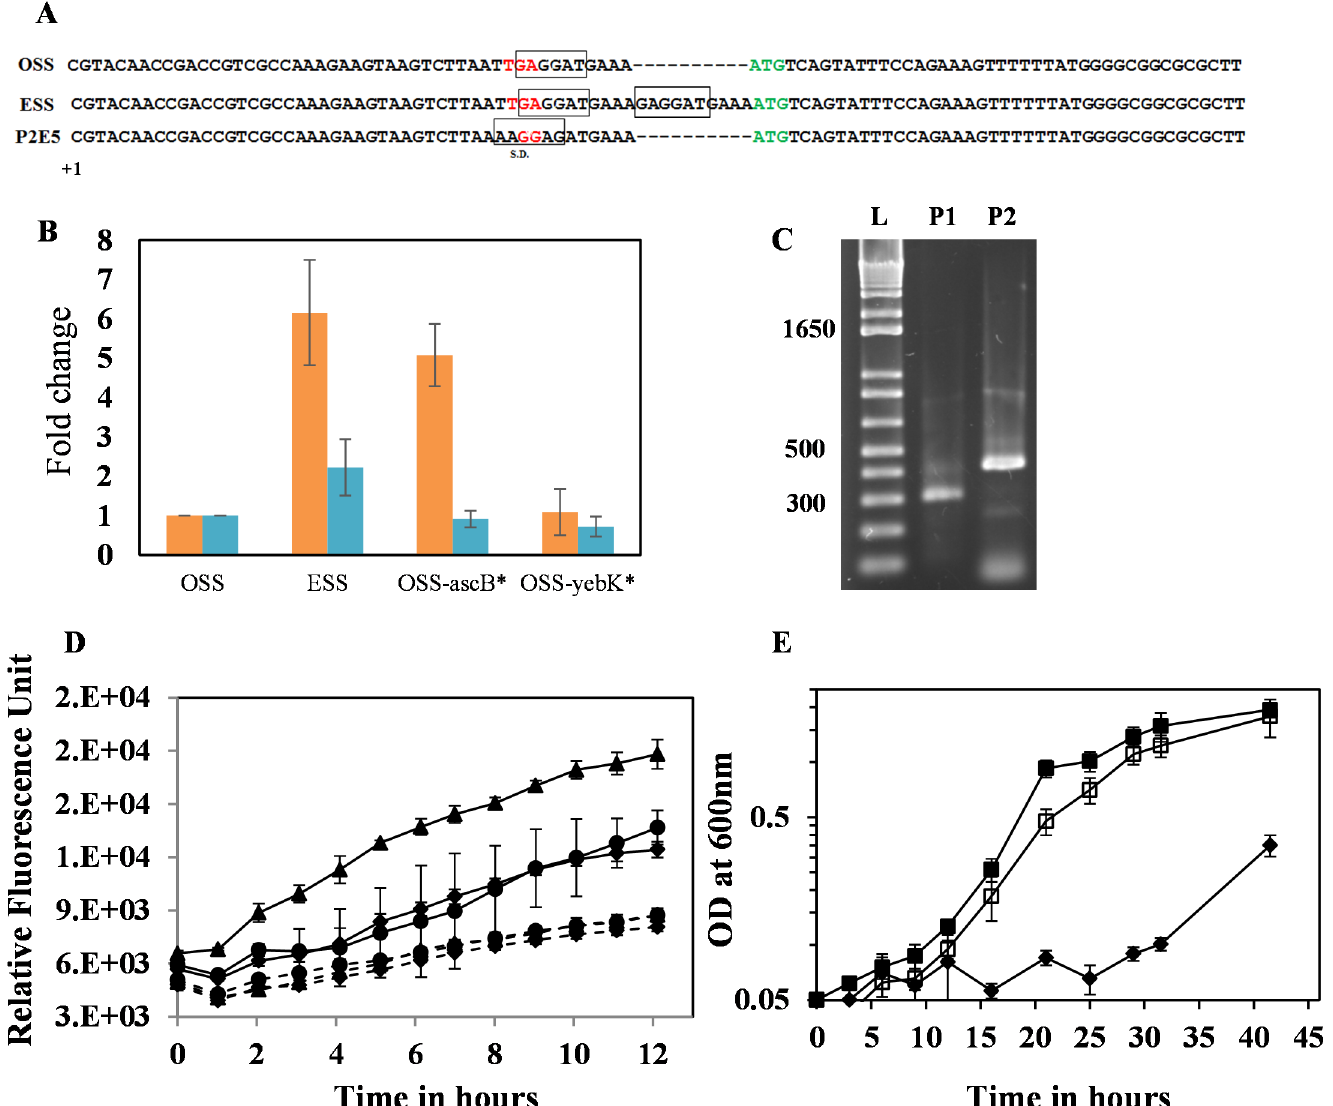
Fig 2. (A) Figure indicating the predicted RBS of OSS and the duplicated sequence observed in strain ESS. The two putative RBS of strain ESS are shown in boxes. The figure also indicates the mutated RBS in strain P2E5 obtained through genome engineering. The new transcription start site of ascB gene was marked as +1. (B) Fold change in the expression level of ascB ( orange ) or ascF ( blue ) in ESS, OSS- yebK * , and OSS- ascB * relative to the expression of the corresponding genes in strain OSS. Error bars indicate the standard deviation of experiments performed in triplicate. (C) 5' RACE PCR to map the location of TSS for ascF and ascB . P1 corresponds to the transcript amplifiable by ascF _RACE_RP and is expected to be around 262 bp; P2 corresponds to the transcript amplifiable by ascB _RACE_RP and is expected to be around 1995 bp. The RACE PCR product of ascF corresponds to the expected size of P1, whereas the RACE PCR product of ascB was smaller than the expected size corresponding to the P2 transcript, indicating the possibility of new TSS. (D) Assay of putative promoter within the asc operon. The sequences from +391 from the start codon of ascF to the end of the operon were cloned into the Eco RI and Kpn I site of pProbe-NT' vector. Solid lines – pProbe-A5; dotted lines – pProbe-NT'; solid circle – MG1655; solid diamond – MG1655- Δ P ascG - ascB :: frt , and solid triangle – MG1655- Δ chbB - chbF :: frt . (E) Comparison of growth on cellobiose. OSS – closed diamond ; OSS- ascB * – closed square ; OSS-P2E5 – open square . Error bars indicate the standard deviation of experiments performed in